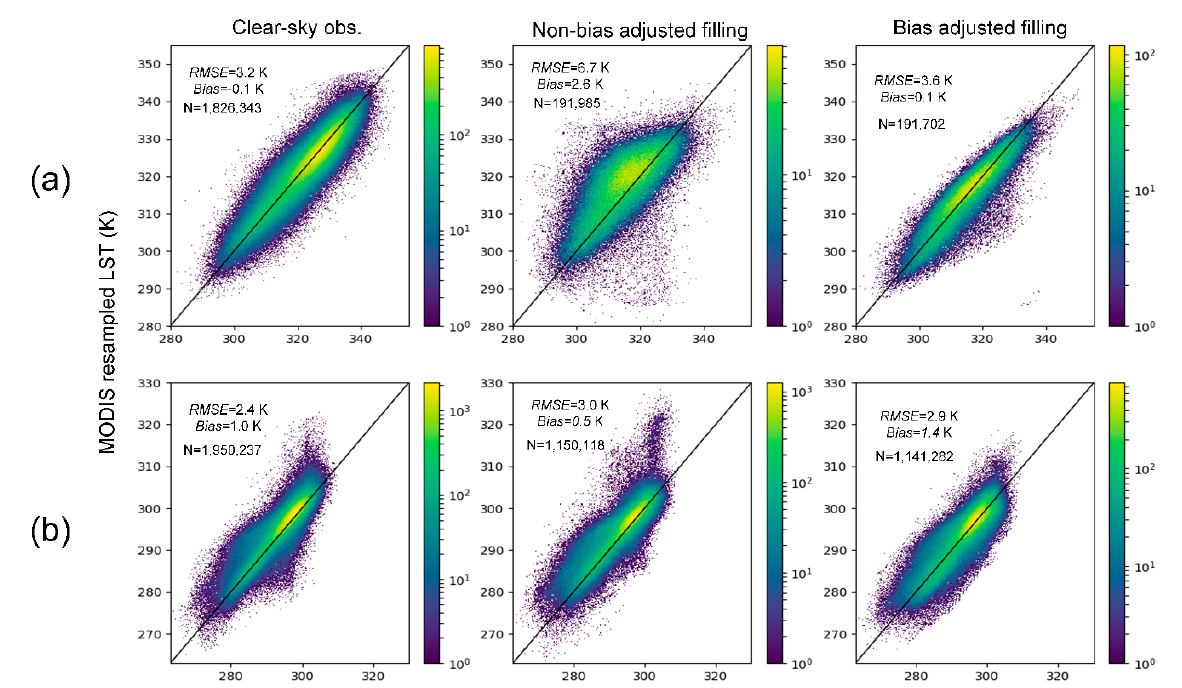
Figure 8. Comparison of Aqua MODIS and Meteosat SEVIRI-derived land surface temperatures (LSTs). ( a ) day-time data and ( b ) night-time data. MODIS data includes both the clear-sky MODIS LSTs from MYD11A and that output from Step 1 and Step 2 of the cloud gap-filling methodology detailed in Section 3. Colour bars indicate the number of co-located observations within the plotting space.